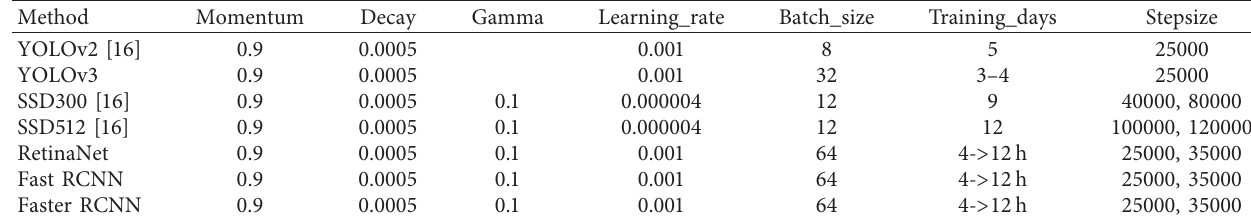
Table 2: The parameters of